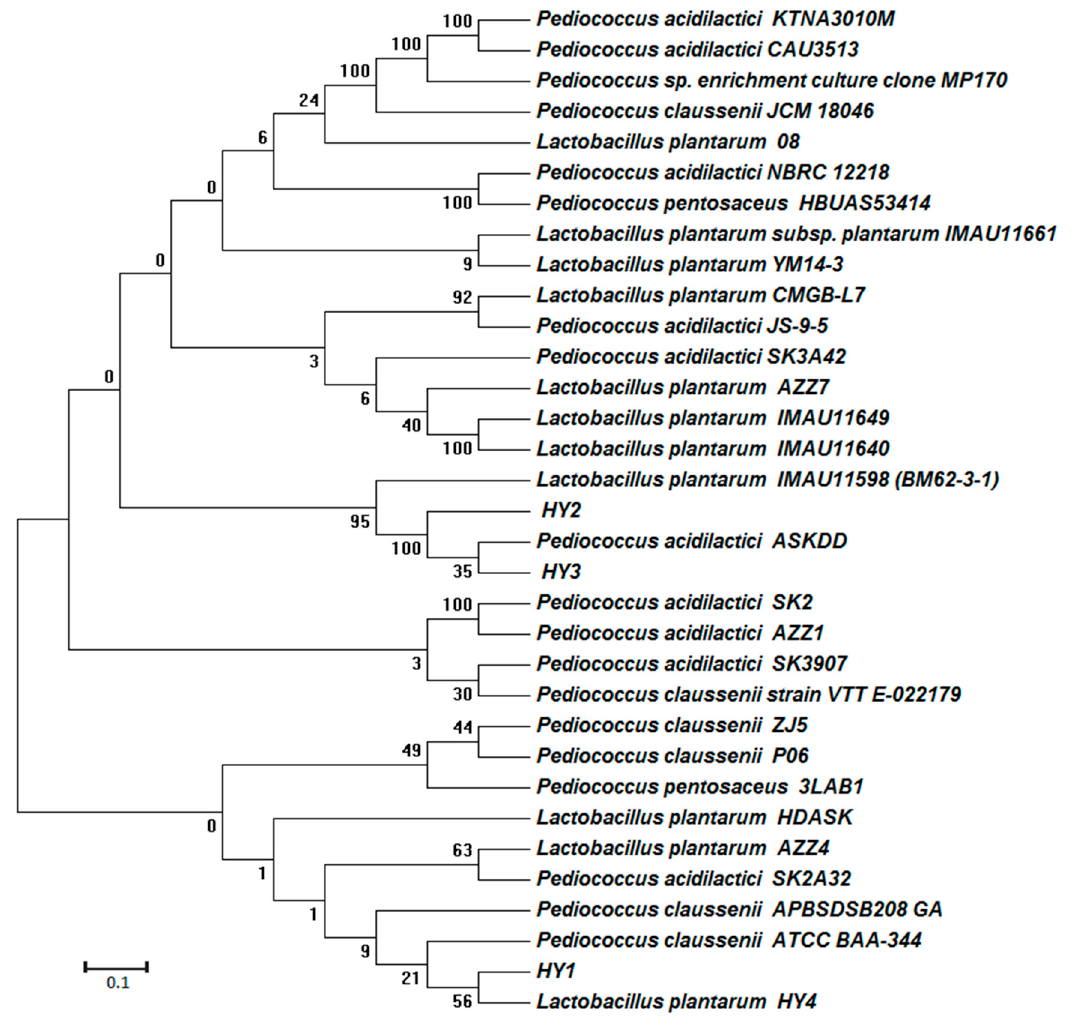
Figure 1. A phylogenetic tree showing the position of strains HY1, HY2 and HY3 based on 16S rRNA sequences constructed by the neighbourhood-joining method. Numerals at the nodes indicate bootstrap values (%) derived from 1000 replications.